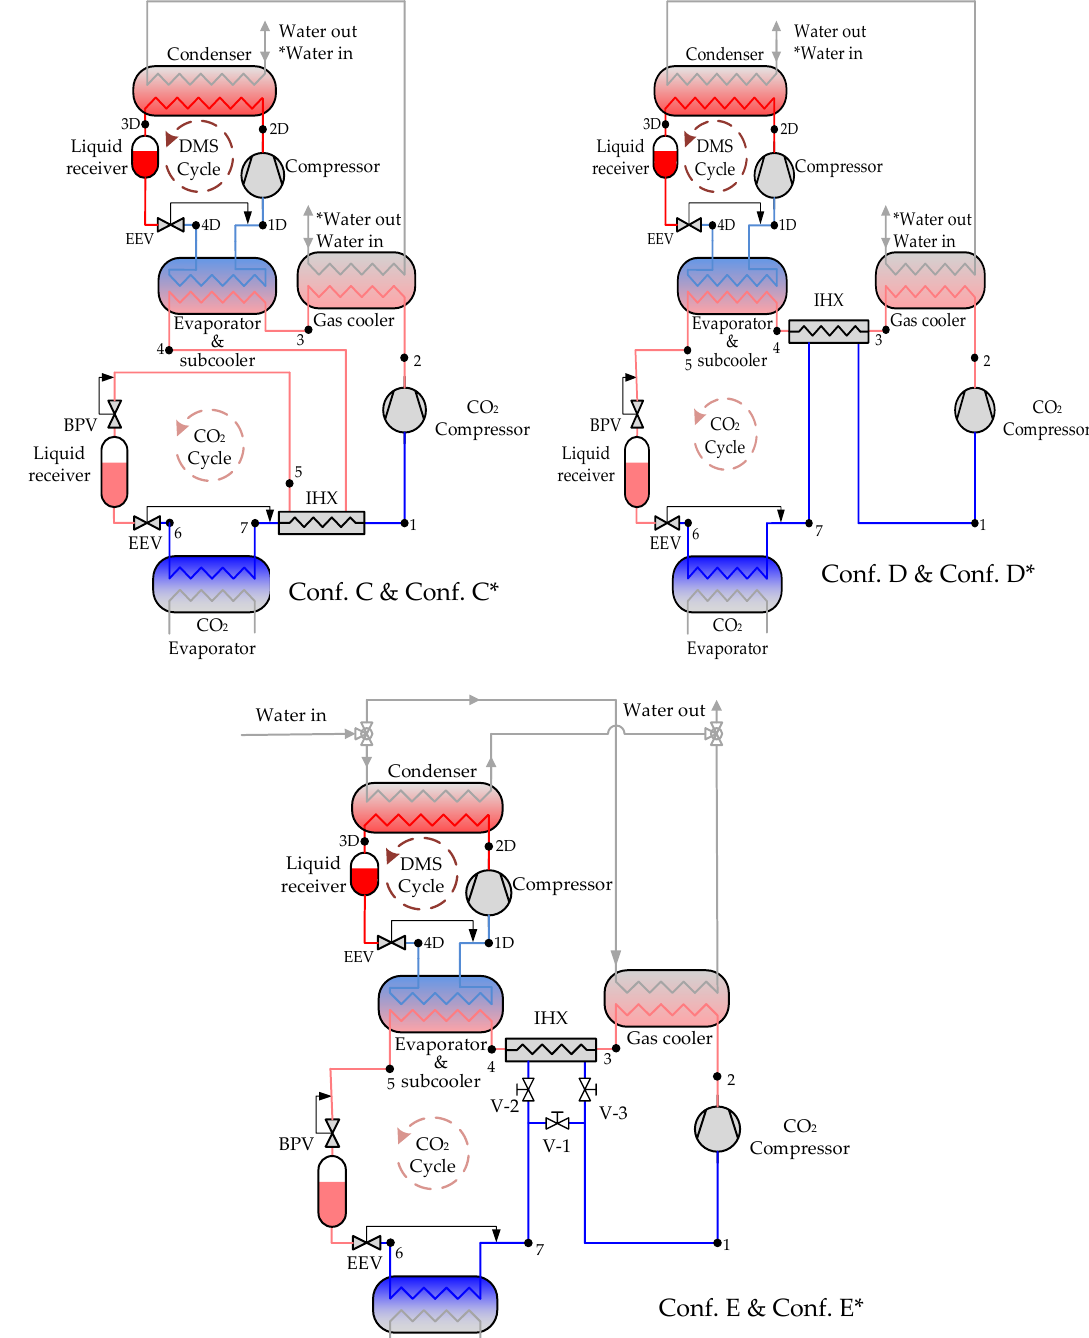
where ∆ h CO 2 and ∆ h R 1234 yf are respectively the enthalpy change of CO 2 and R1234yf at the heat exchanger acting as CO 2 cycle subcooler and R1234yf cycle evaporator.